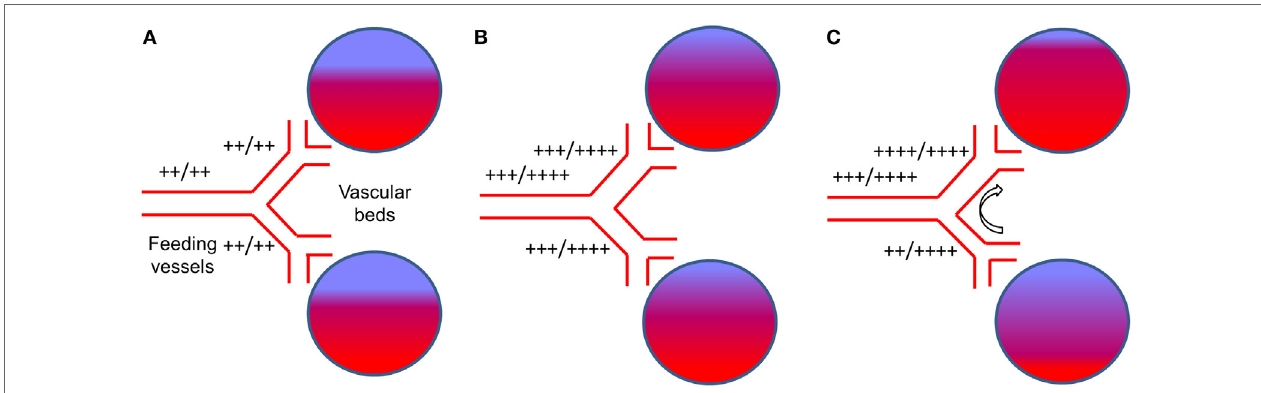
FiGUre 2 | the effect of a global vasodilatory stimulus on regional blood flow with normal vasculature and with impaired regional vascular response . (a) The normal state at normocapnia. The extent of red color in the vascular beds represents actual blood flow and blue color represents potential blood flow. “ ++ / ++ ” beside vessels represents normal blood flow at rest ( ++ ) compared to the flow demand ( ++ ). This would be the case for normal vasculature and for vasculature that has branches with reduced vasodilatory capacity. (B) With normal vasculature, hypercapnia stimulates increase blood demand by the vascular beds. The vasodilatory demand of the vascular beds combined exceed that of the main feeding vessel (23), which is limiting, i.e., their flow ( +++ ) does not meet demand ( ++++ ). However, the dilatory response capability of each feeding vessel is symmetrical and so is their flow. (C) In the presence of a dysfunctional vessel, a hypercapnic stimulus results in the same demand in the healthy and dysfunctional vessel (i.e., ++++ ). There is a strong vasodilation in the healthy (upper) branch and a weaker vasodilation in the dysfunctional (lower) branch. The inflow from the main vessel is still limiting (i.e., +++ / ++++ ). The direct competition for flow between the vascular beds results in an increased proportion of the flow through the normal vessel ( ++++ ) at the expense of the dysfunctional vessel [flow reduced from +++ in (B) , to ++ ]. This is referred to as vascular